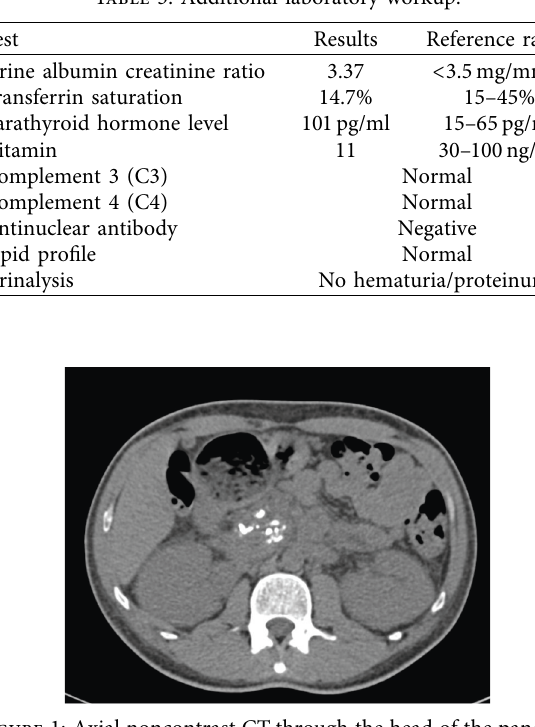
Table 3: Additional laboratory workup.